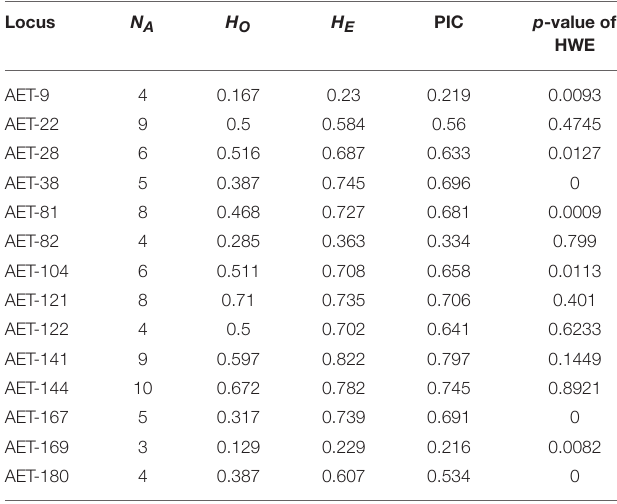
TABLE 2 | Fourteen EST-SSR loci used for assessing genetic differentiation of Actinidia eriantha Locus N A H O PIC